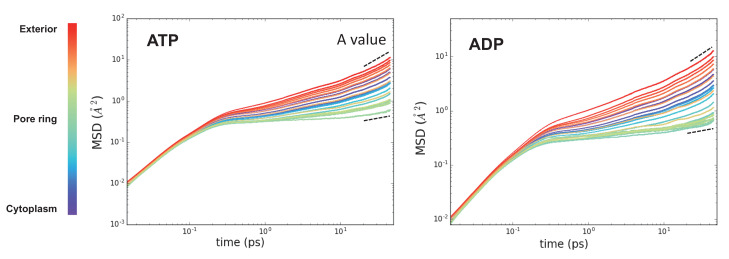
Raw MSD data from Figure 3.These plots represent the time evolved MSD for the waters in each slice along the protein (coloured from purple to red). After about 10 ps, the data fits a simple power law function – highlighted with a dotted black line. Note that these data are averaged over the 31 time points. The perturbation of water dynamics at the centre of the pore is clearly visible in the green traces.